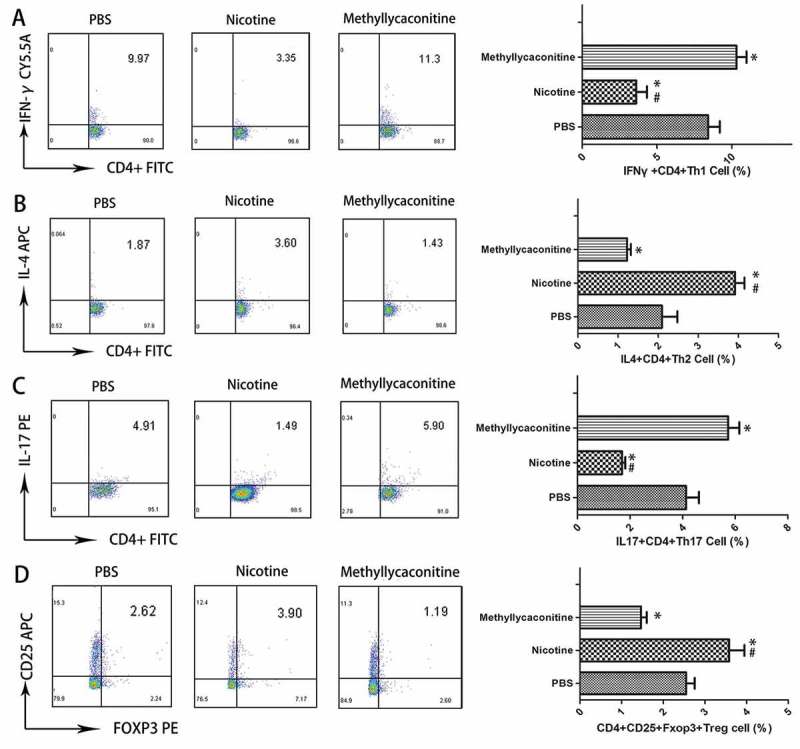
The percentage of Th cell subsets in the spleen from CVB3-infected mice (n = 5 in each group). The percentages of IFN-γ+ CD4+ Th1 and IL-17+ CD4+ Th17 cells were increased in the MLA group, but they were decreased in the nicotine group. CD4, IFN-γ, IL-4, IL-17, CD25 and Foxp3 were labeled by FITC, PE-CY5.5, APC, PE, APC, and PE, respectively. A, B, C and D are the representative results for each group and the percentage of double positive cells. *P < 0.05 versus the PBS group and #P < 0.05 versus the methyllycaconitine group.